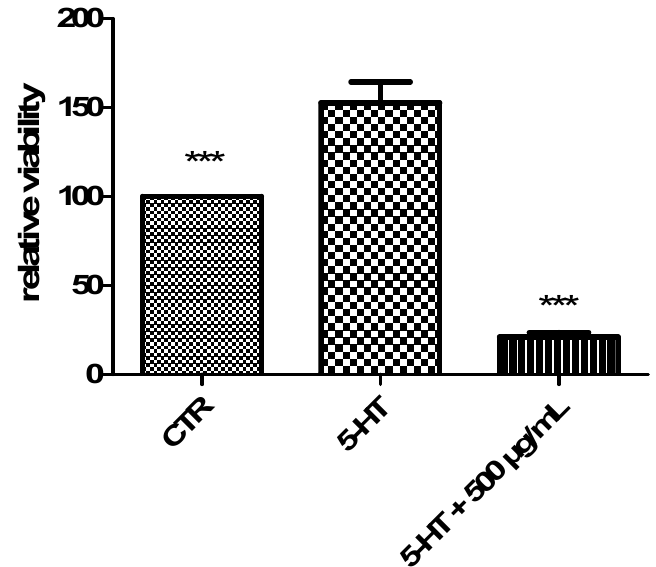
Figure 6. Antiproliferative effect of C. minima hydroalcoholic extract 500 µg/mL on human colon cancer HCT116 cell viability [3-(4,5-dimethylthiazol-2-yl)-2,5-diphenyltetrazolium bromide (MTT) test] induced by the mitogen stimulus 5-HT (1 ng/mL). ANOVA, p < 0.0001; *** p < 0.001 vs. 5-HT group.